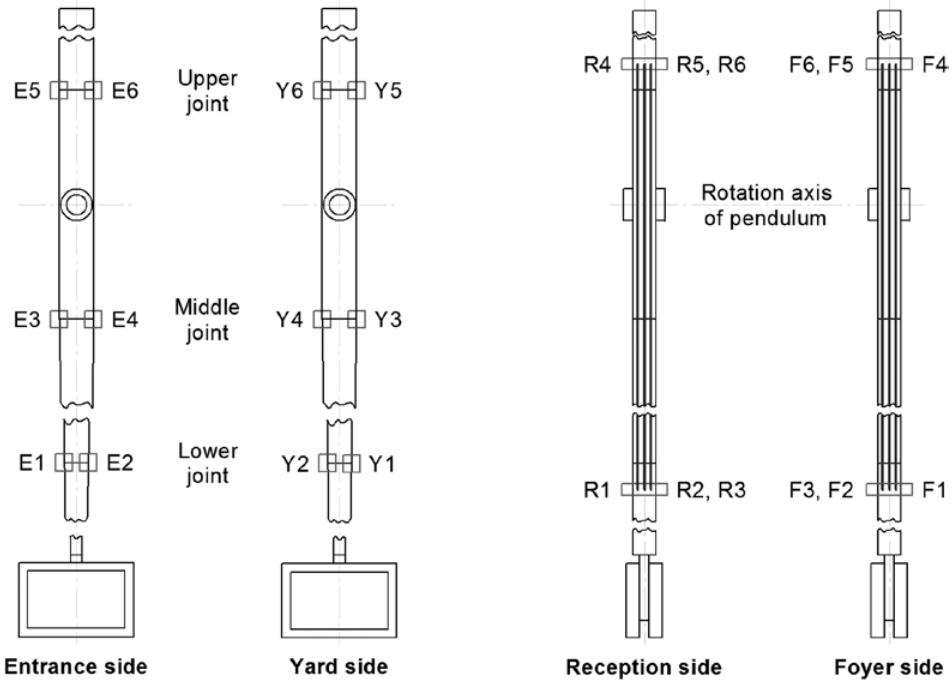
Figure 14. Location and denomination of butt welds (entrance/yard side) and prestress measuring points at CFRP laminate ends (reception/foyer